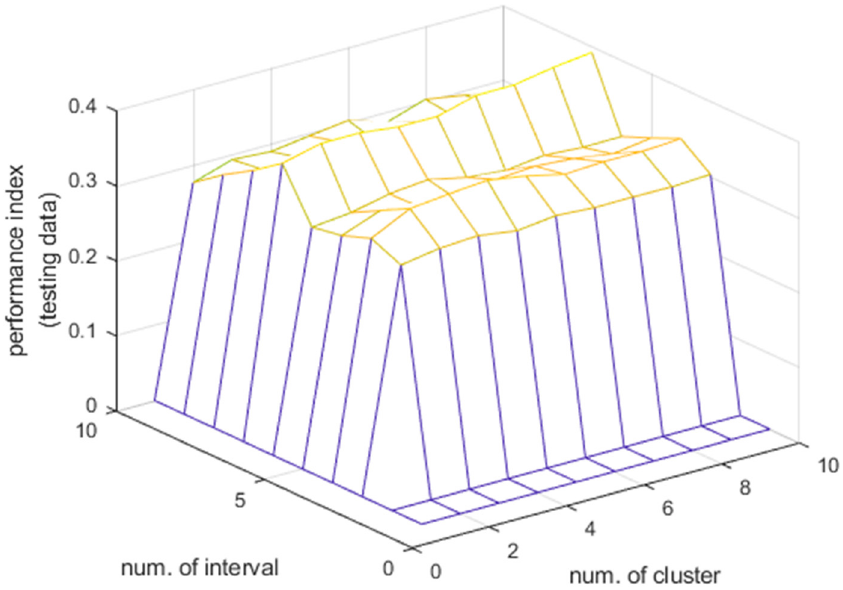
Figure 10. Prediction results for interval-based IGM (Case 1).